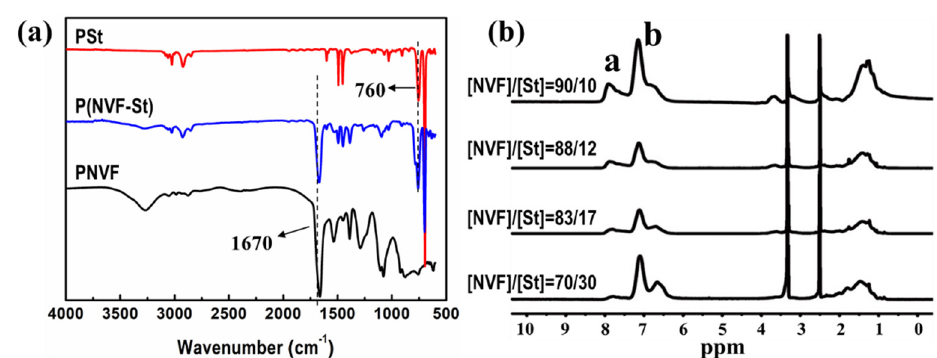
Figure 1. Fourier transform infrared spectroscopy (FTIR) spectra ( a ) and nuclear magnetic resonance spectroscopy ( 1 H-NMR) spectra ( b ) of copolymerizing products.